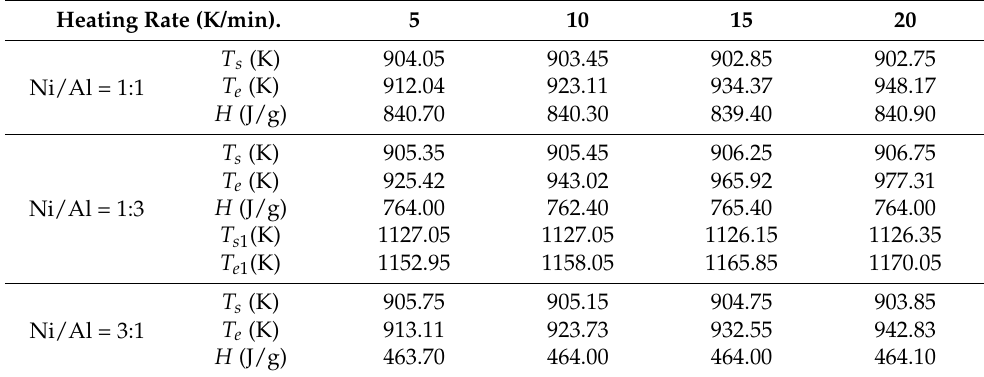
Table 1. Thermal reaction parameters of Ni/Al